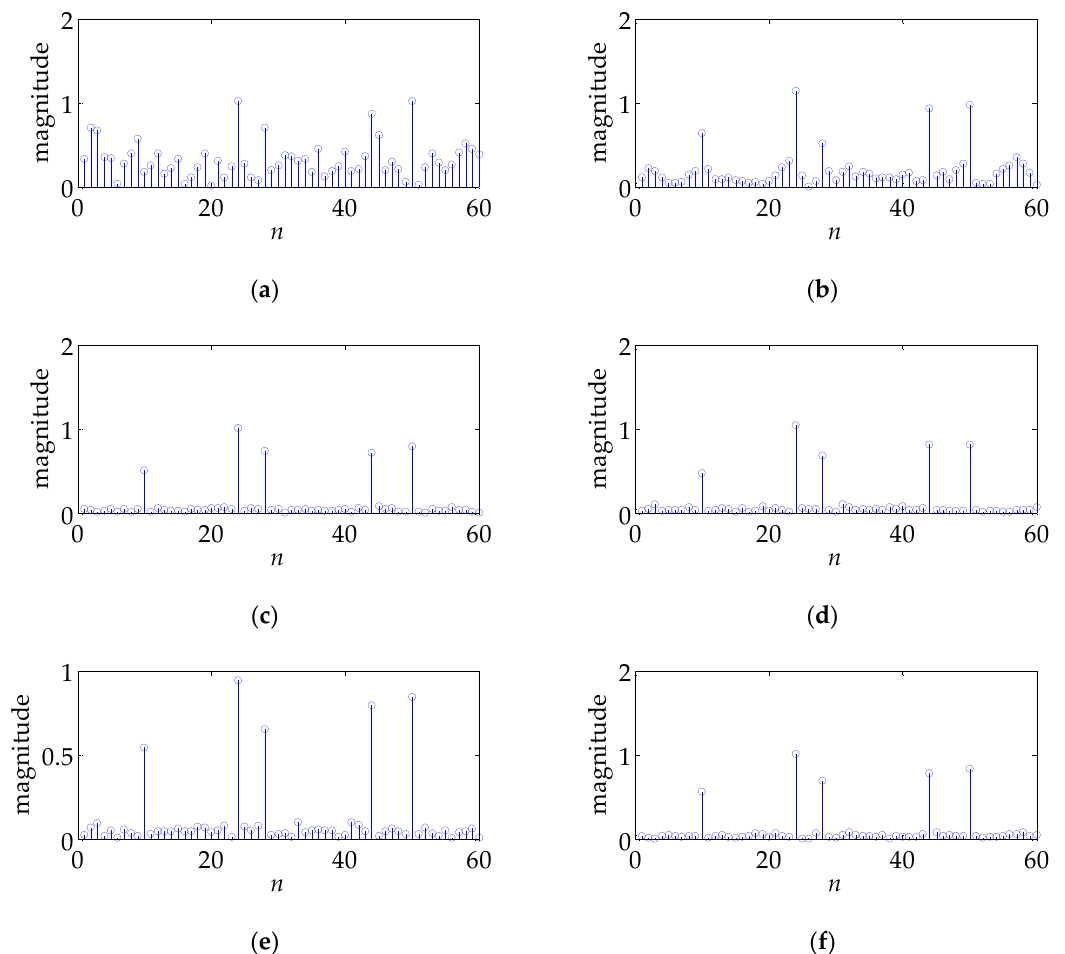
Figure 6. The profiling results using different waveforms in the white noise. ( a – f ) correspond to waveforms s 1 ∼ s 6